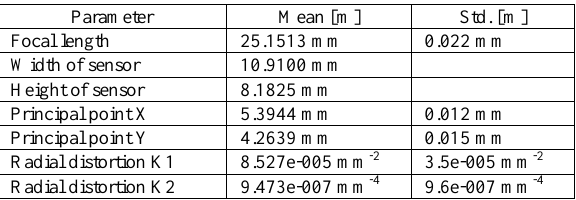
Table 6. Results of thermo camera calibration 6. TIME SYNCHRONIZATION